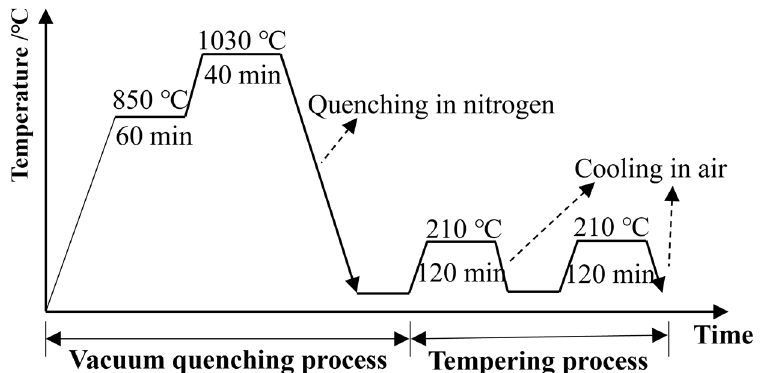
Figure 1. The conventional quenching/tempering process of cold worked die steels.